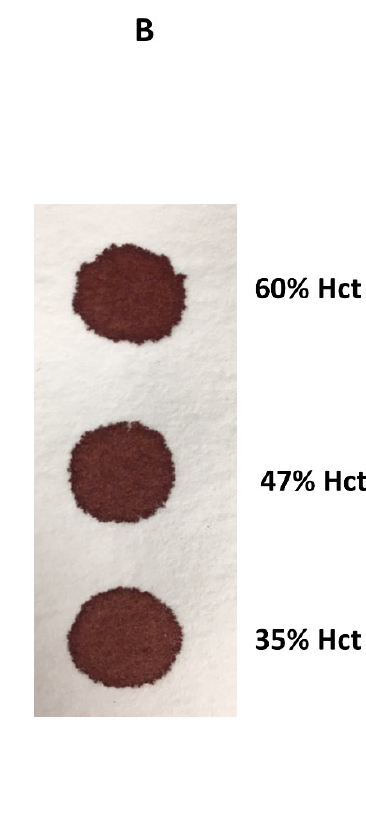
Figure 3. Effect of sample volume, punch location and compression of the sample on DBS phenylalanine concentrations in a patient with phenylketonuria (PKU) (results are a mean of n = 3). C, central punch; P, peripheral punch; Comp, compressed.